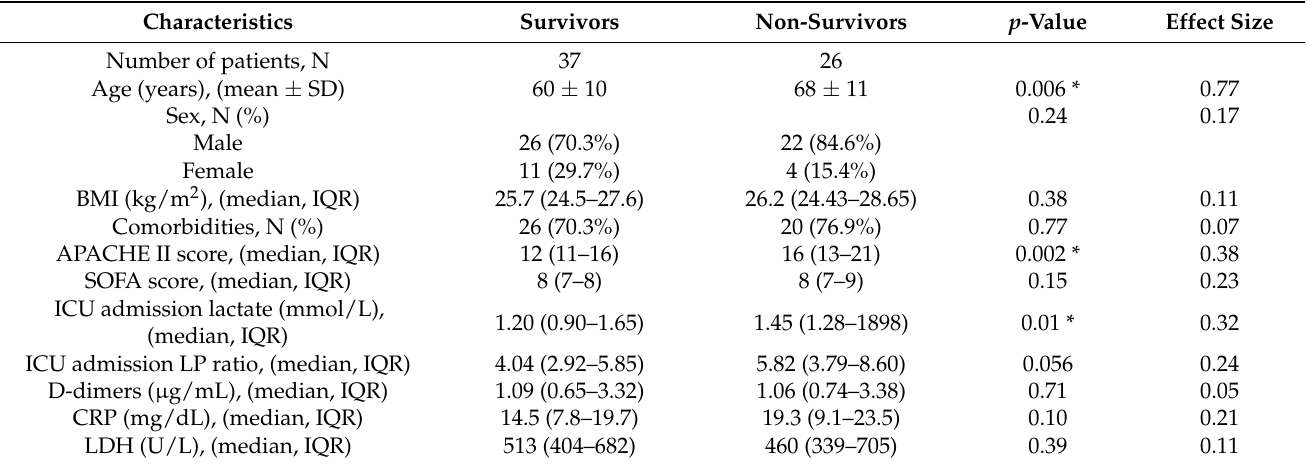
Table 2. ICU admission clinical characteristics and laboratory data in survivors and non-survivors among critically ill COVID-19